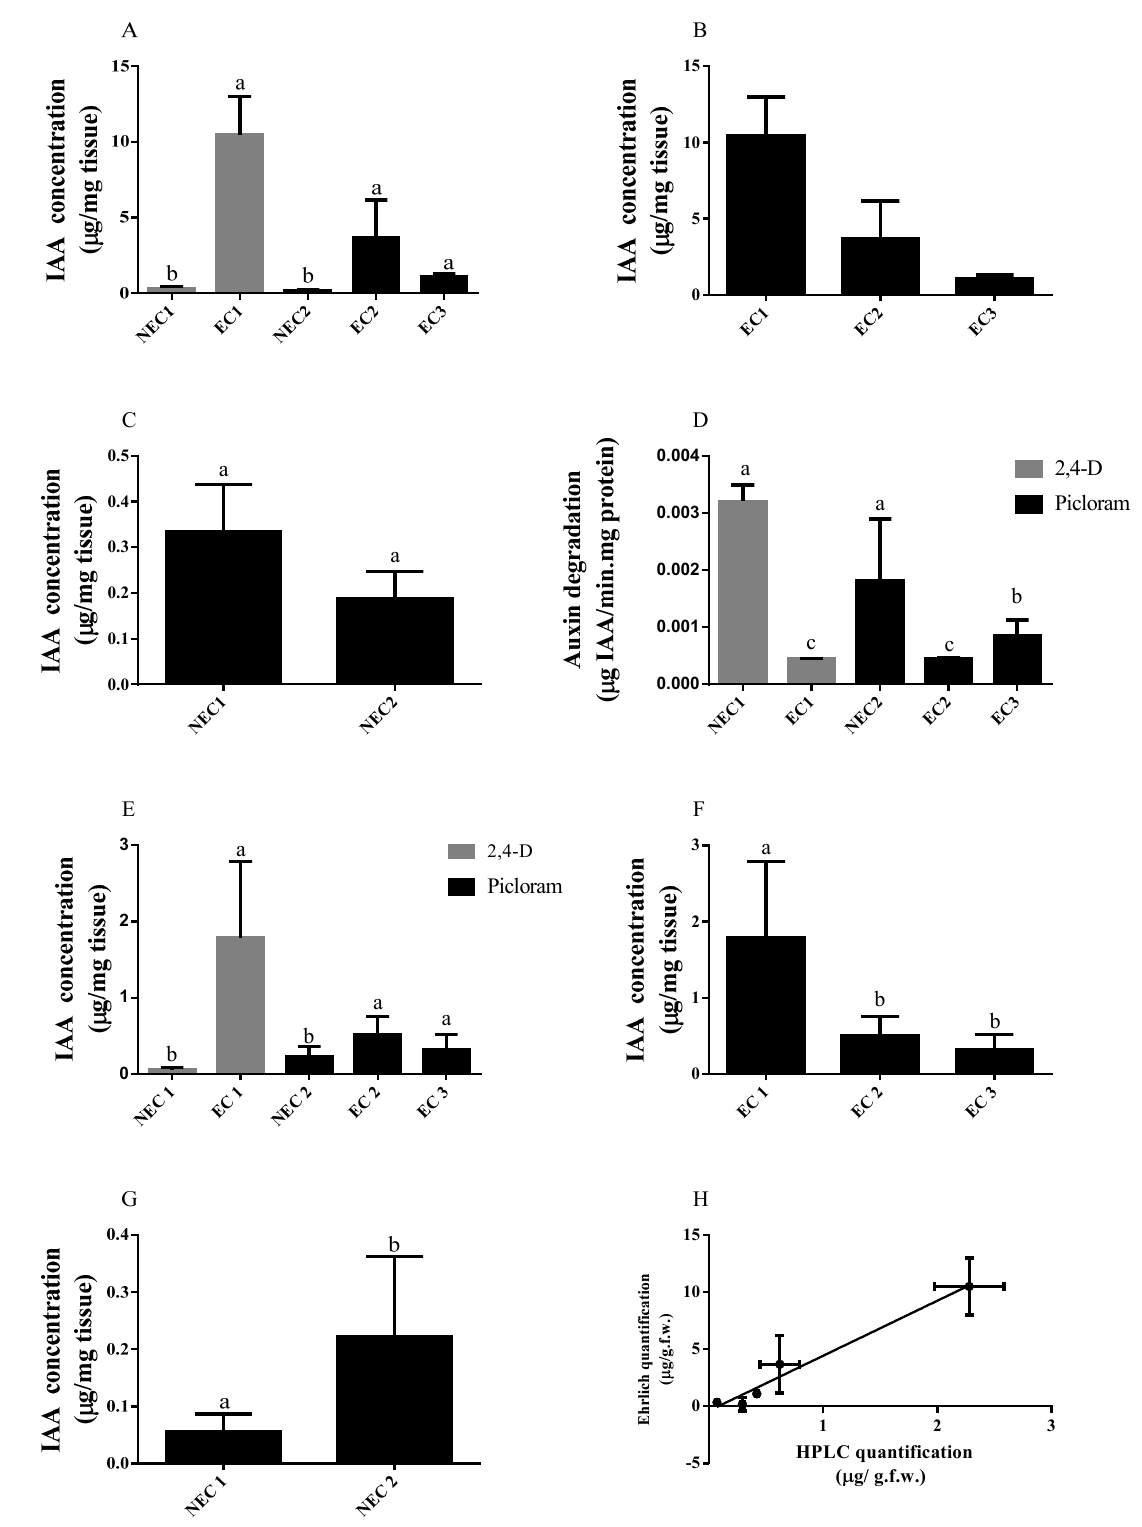
the non-embryogenic tissue (Figure 3C) showed no differences between non-embryogenic tissues, regardless of biological origin.